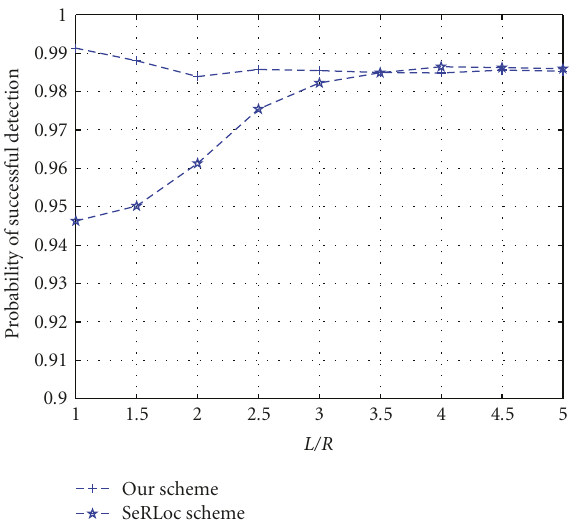
Figure 5: Probability of wormhole attack detection: Simulation versus Theoretical.